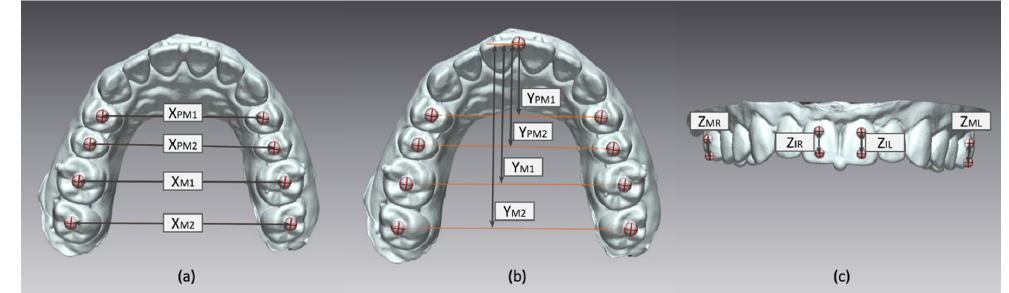
Figure 3. Linear measurements according to X-, Y-, and Z-axes. ( a ) Linear measurements on X-axis: X PM1 , between right and left first premolars; X PM2 , between right and left second premolars; X M1 , between right and left first molars; and X M2 , between right and left second molars. ( b ) Measurements on Y-axis: Y PM1 , from the incisor center to the virtual line between right and left first premolars; Y PM2 , from the incisor center to the virtual line between right and left second premolars; Y M1 , from the incisor center to the virtual line between right and left first molars; and Y M2 , from the incisor center to the virtual line between right and left second molars. ( c ) Measurements on Z-axis: Z MR , between the balls on right first molar; Z IR , between the balls on right incisor; Z IL , between the balls on left incisors; and Z ML , between the balls on left first molars. Note that the center of reference ball is marked with cross sign and the measurements are marked with double-headed arrows.